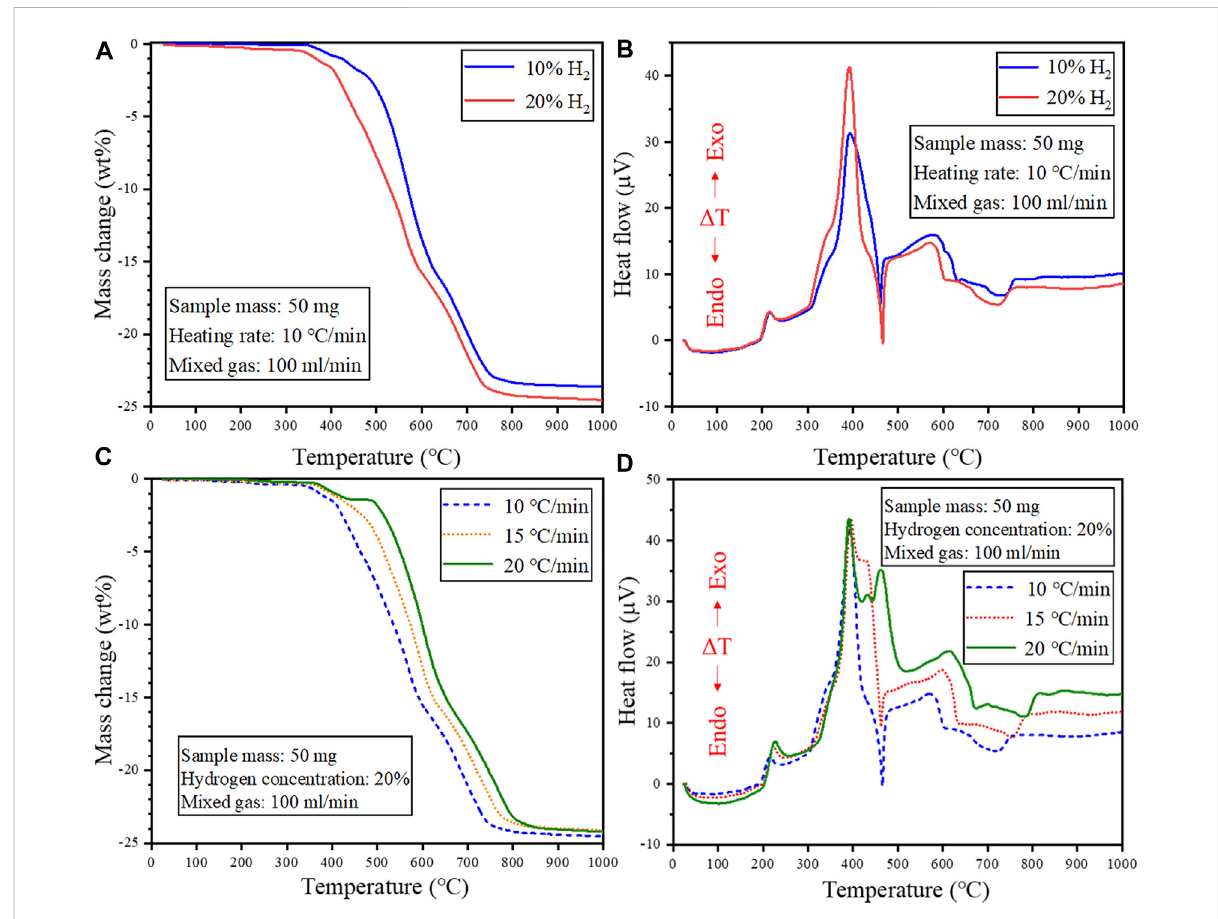
FIGURE 5 EffectofH 2 concentrationonthereductionbehaviorofcathodepowdersundernon-isothermalreductionconditions (A) TGand (B) DTAcurve. Effect of heating rate on the reduction behavior of cathode powders under non-isothermal reduction conditions (C) TG and (D) DTA